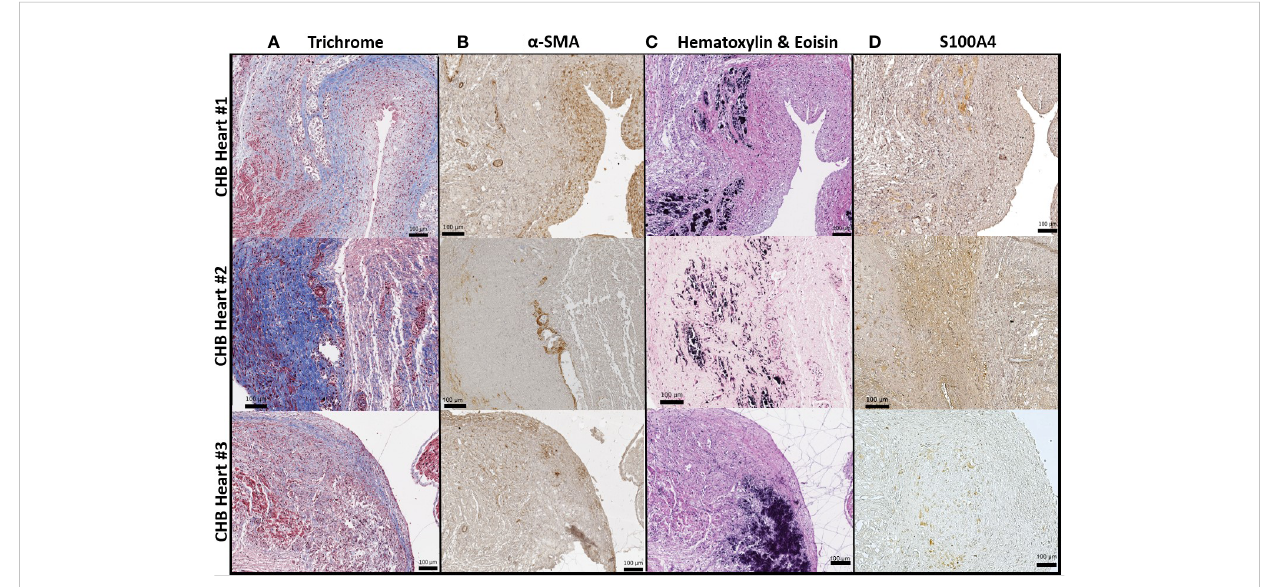
FIGURE 2 a -SMA + fi broblasts and S100A4 + fi broblasts found largely at architecturally distinct sites of the injured heart. As in Figure 1, S100A4 positive expression (D) in the injured hearts was limited to regions with dystrophic calci fi cation (C) , visualized by staining with hematoxylin and eosin. In contrast, a -SMA + cells were localized to the epicardium (diffuse brown cells, (B) in zones with evident fi brosis, con fi rmed via Trichrome (Masson) staining (A) .